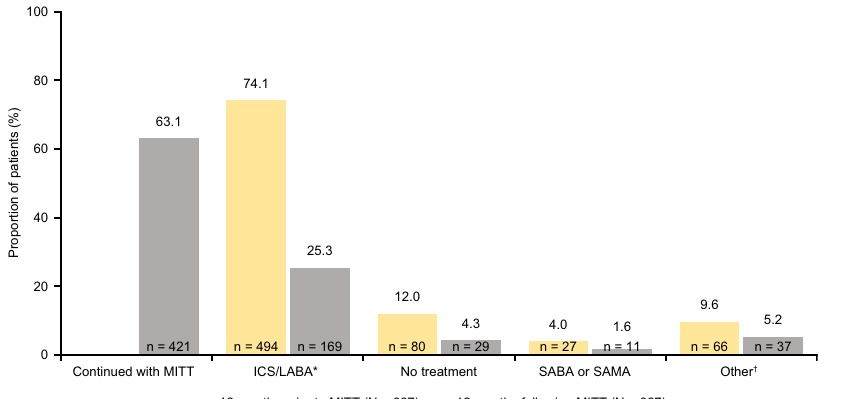
Fig. 5 Treatment patterns in the 12 months prior to (pre-index) and 12 months following (post-index) MITT initiation among patients with severe exacerbations. Percentages may not total 100% due to rounding. *ICS/LABA category includes: ICS/LABA, ICS/LABA/anti- leukotrienes, ICS/LABA/OCS, ICS/LABA/OCS/SAMA, ICS/LABA/anti-leukotrienes/OCS; † other category includes: ICS, ICS/LAMA, ICS/anti- leukotrienes, ICS/OCS, ICS/OCS/LAMA, LABA/LAMA, LABA/anti-leukotrienes, LAMA, LAMA/anti-leukotrienes, anti-leukotrienes, OCS, OCS/ LAMA, OCS/LAMA/anti-leukotrienes. ICS inhaled corticosteroid, LABA long-acting β 2 -agonist, LAMA long-acting muscarinic antagonist, MITT multiple-inhaler triple therapy, OCS oral corticosteroid, SABA short-acting β 2 -agonist, SAMA short acting muscarinic antagonist.